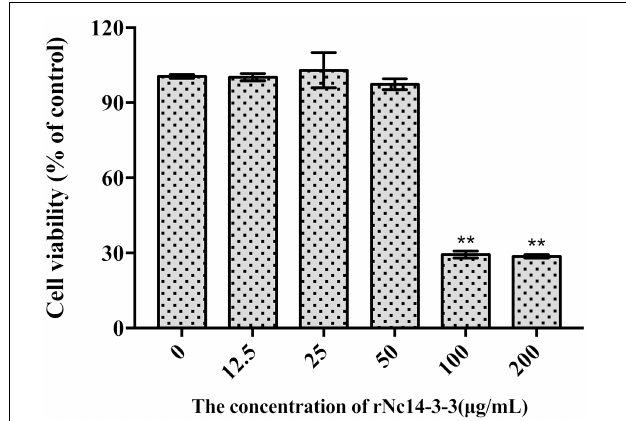
FIGURE 3 | Effect of Recombinant Nc14-3-3 on the cell viability of PMs. Mouse PMs were cultured with different protein concentrations (0, 12.5, 25, 50, 100, 200 µ g/mL) for 24 h. Cell viability was determined by the CCK-8 assay. ∗ P < 0.05; ∗∗ P < 0.01 for the rNc14-3-3 group versus the PBS group. CCK-8, cell counting